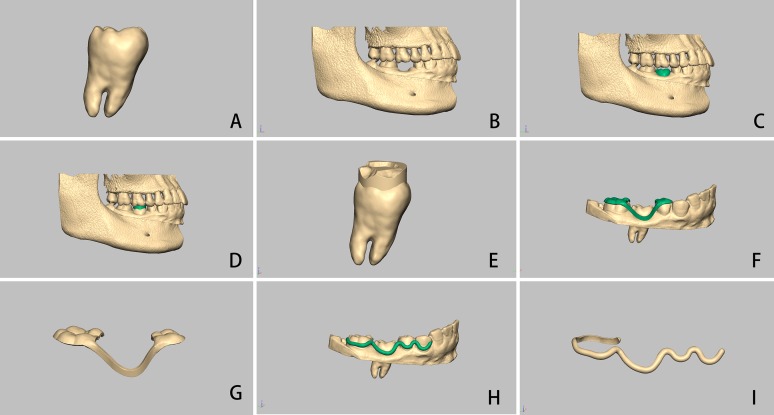
Computer-aided autotransplantation of tooth and virtual design of a series of novel surgical guides.(A) The donor tooth was isolated from CBCT data, (B) digital dentition was registered onto the digital jaw, (C) the digital donor tooth was transplanted onto the recipient site, (D and E) a local surgical split was generated between occlusal surfaces of the donor tooth and its opposite tooth and attached to the donor tooth, (F and G) individual surgical template was supported by adjacent teeth with a connecting bar, (H and I) virtually designed arch bar.